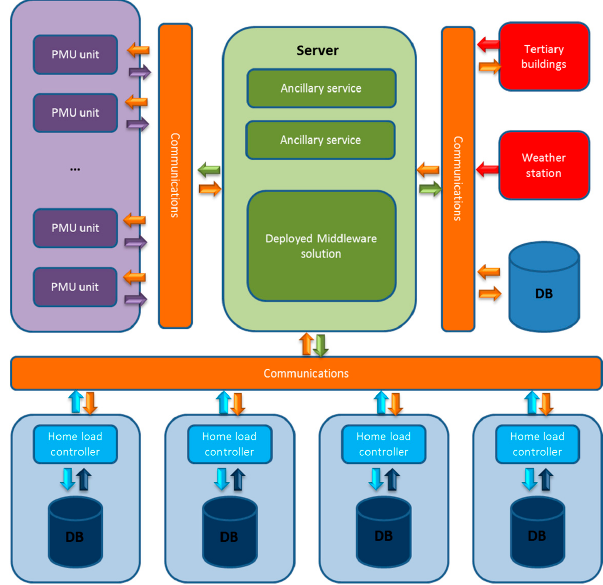
Figure 6. Deployment of hardware and software entities in Steinkjer demo lab.